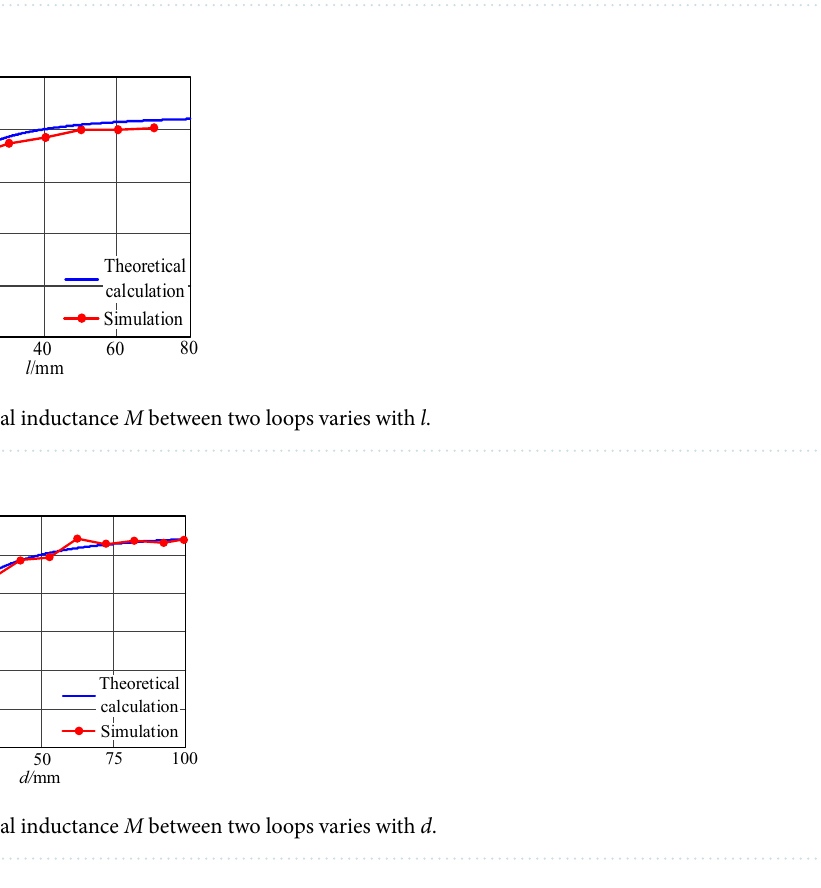
(12) M pri = M loop 2 + M loop 3 + M loop 4 .